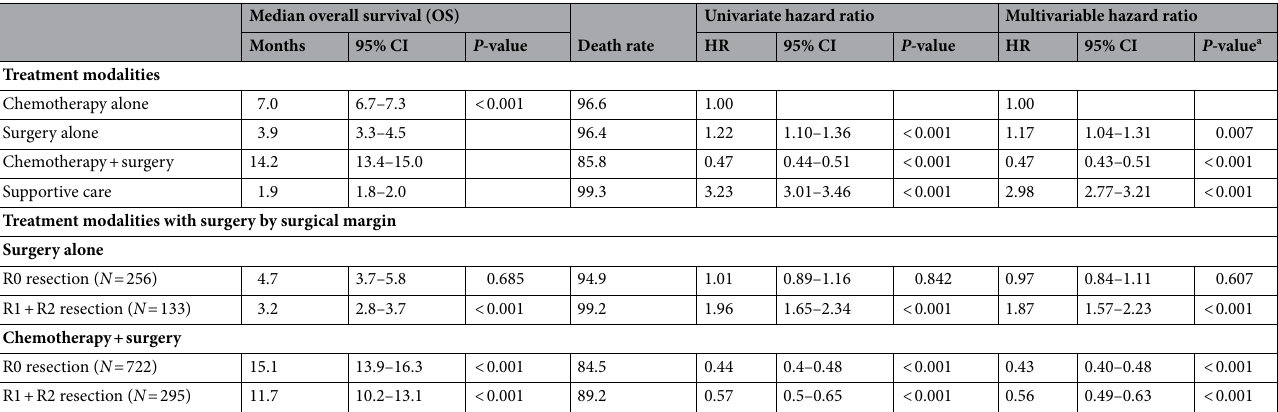
Table 3. The median overall survival and Cox regression analysis of metastatic gastric cancer by treatment modalities in Taiwan from 2008 to 2015. a Adjusted by sex, age at diagnosis, year of diagnosis, tumor grade, and hospital